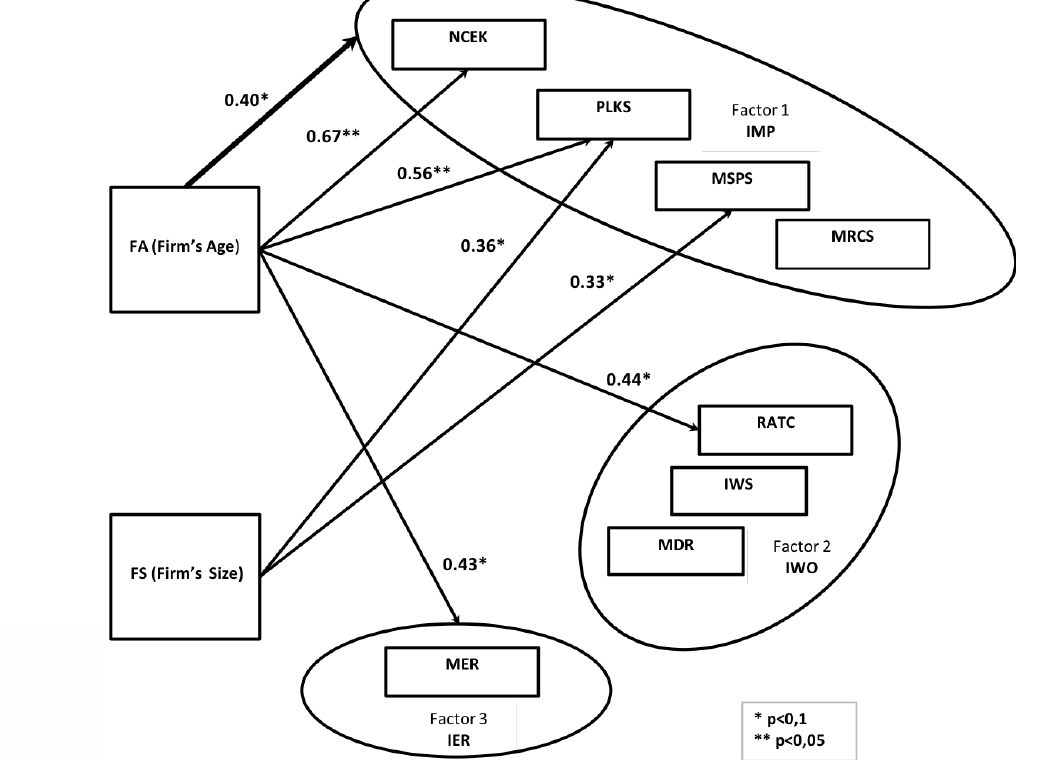
Fig. 2. Graphical model of the significant relations